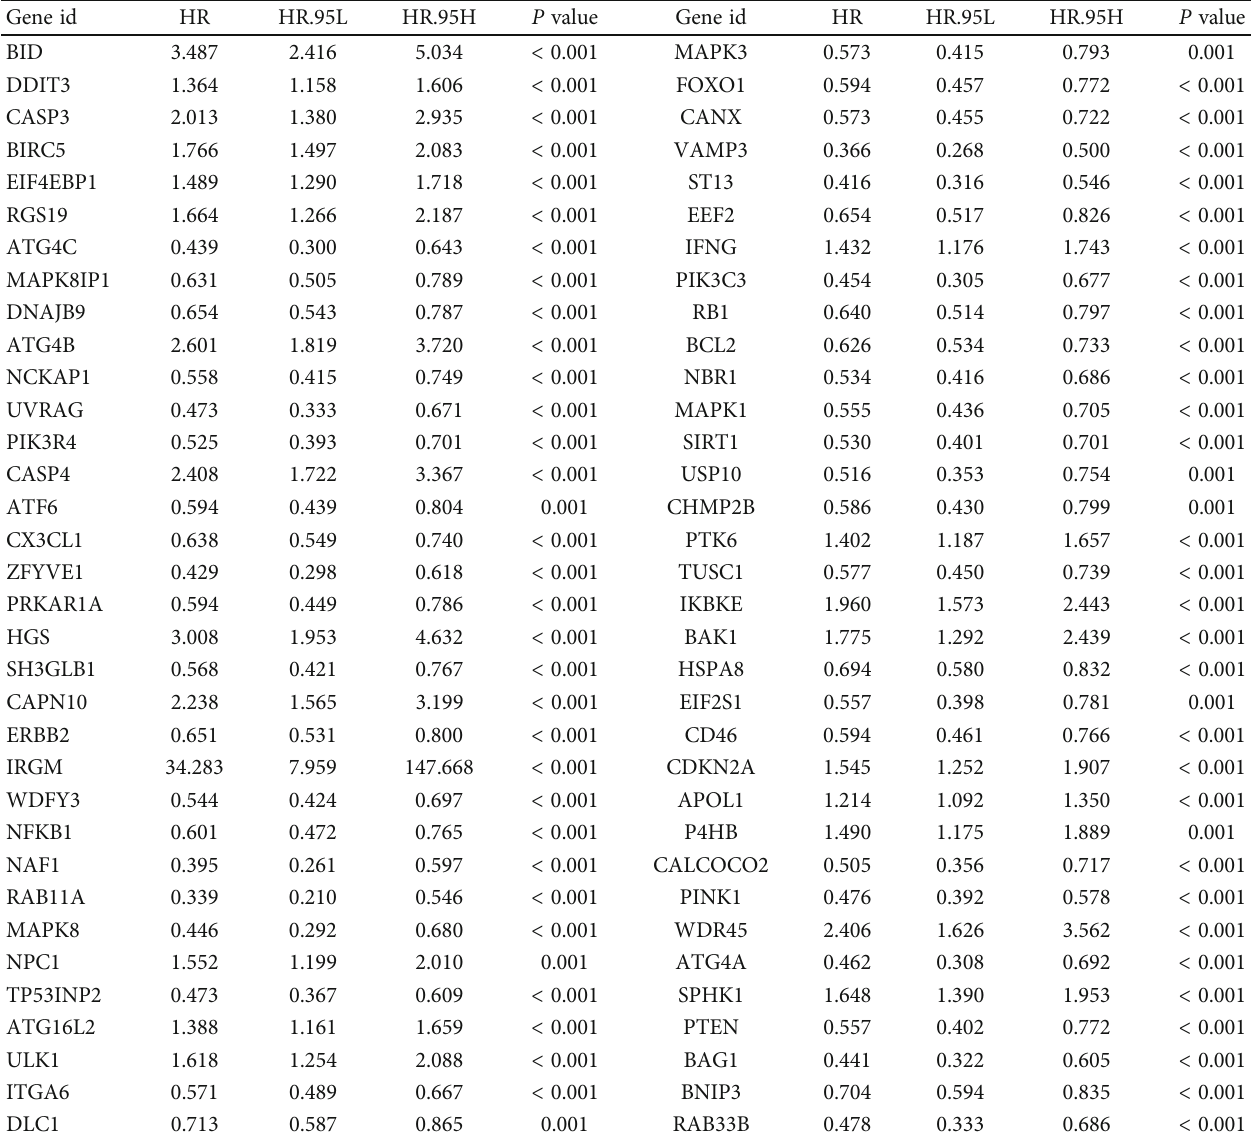
Table 2: OS-related ARGs in the univariate Cox regression